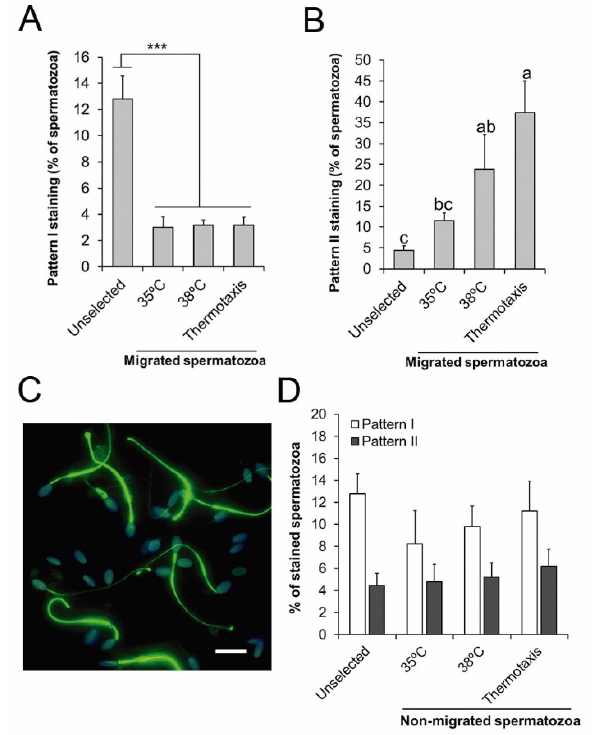
Figure 5. Protein tyrosine phosphorylation in the thermotaxis assay. ( A , B ) Percentage of spermatozoa showing staining patterns I or II for tyrosine phosphorylation in the unselected sample, in the spermatozoa migrating across constant temperatures (35 or 38 °C), or across a temperature gradient (from 35 to 38 °C, thermotaxis). ( C ) Representative micrograph of immunofluorescence for tyrosine phosphorylation (green) in stallion spermatozoa migrating by thermotaxis. Nuclei were labelled with Hoechst 33342 (blue). Bar = 10 µm. ( D ) Percentage of spermatozoa showing staining patterns I and II for protein tyrosine phosphorylation in the unselected sample or in those spermatozoa that did not migrate during the thermotaxis assay in the conditions described above. *** p = 0.001, a, b, c different letters indicate significant differences ( p < 0.05, n = 6).